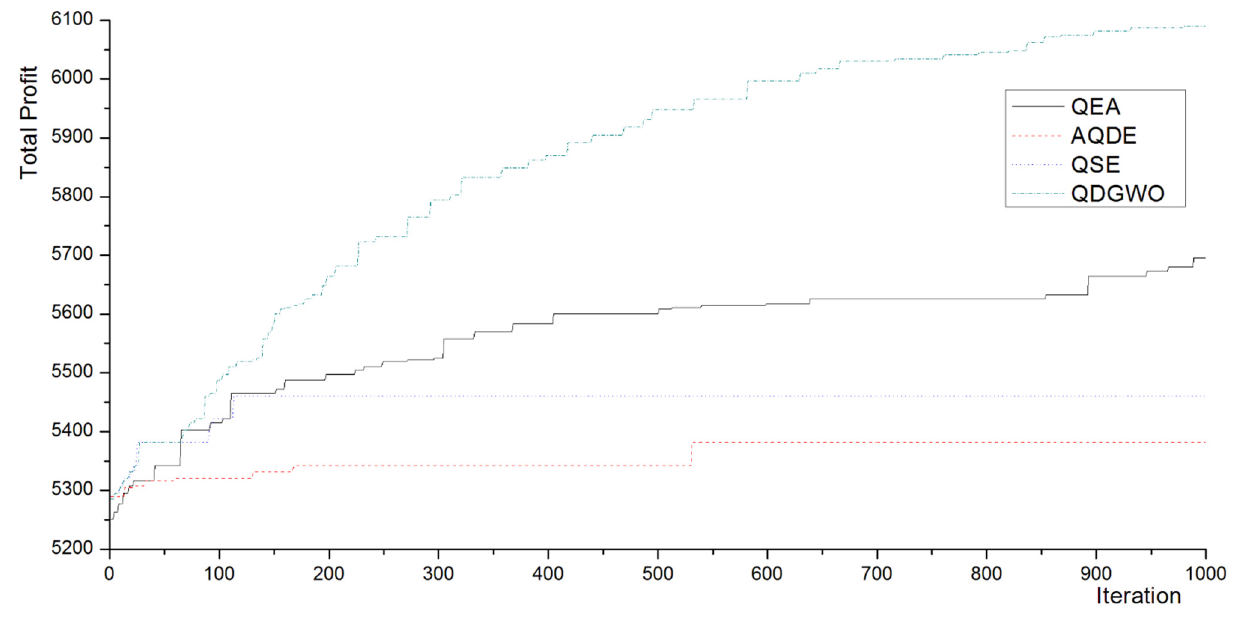
Figure 6. Best profits for the 0-1 knapsack problems (1000 items in Experiment 1).